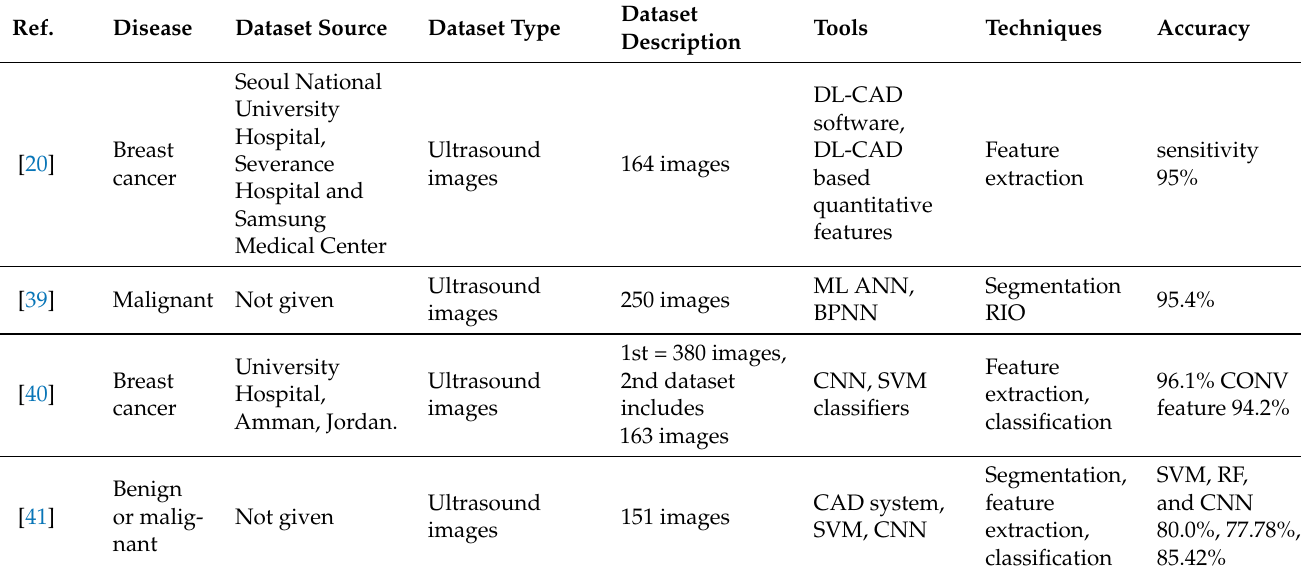
Table 1. Existing techniques on ultrasound images